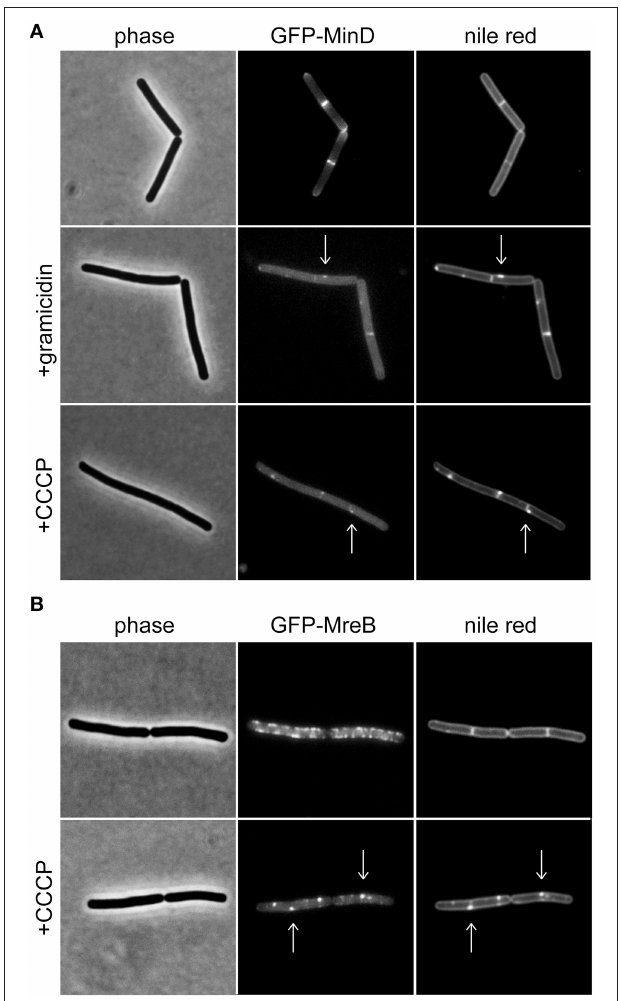
FIGURE 1 | Membrane potential-dependent localization pattern of MinD and MreB. (A) Phase contrast images (left panel) of B. subtilis cells expressing GFP-MinD (middle panel), and stained with fluorescent membrane dye nile red (right panel) in the absence and presence of the small cation channel forming antimicrobial peptide gramicidin (1 µ M), or H + ionophore CCCP (100 µ M). Note the loss of polar membrane associated localization pattern upon depolarization, and a few remaining foci which colocalize with fluorescent nile red foci (arrows). (B) Phase contrast images (left panel) of B. subtilis cells expressing GFP-MreB (middle panel), and stained with fluorescent membrane dye nile red (right panel) in the absence and presence of CCCP (100 µ M). Note the clustering of the protein upon depolarization which triggers the fluorescent nile red foci (arrows). Strains used: B. subtilis KS64 (GFP-MinD), and B. subtilis YK405 (GFP-MreB).